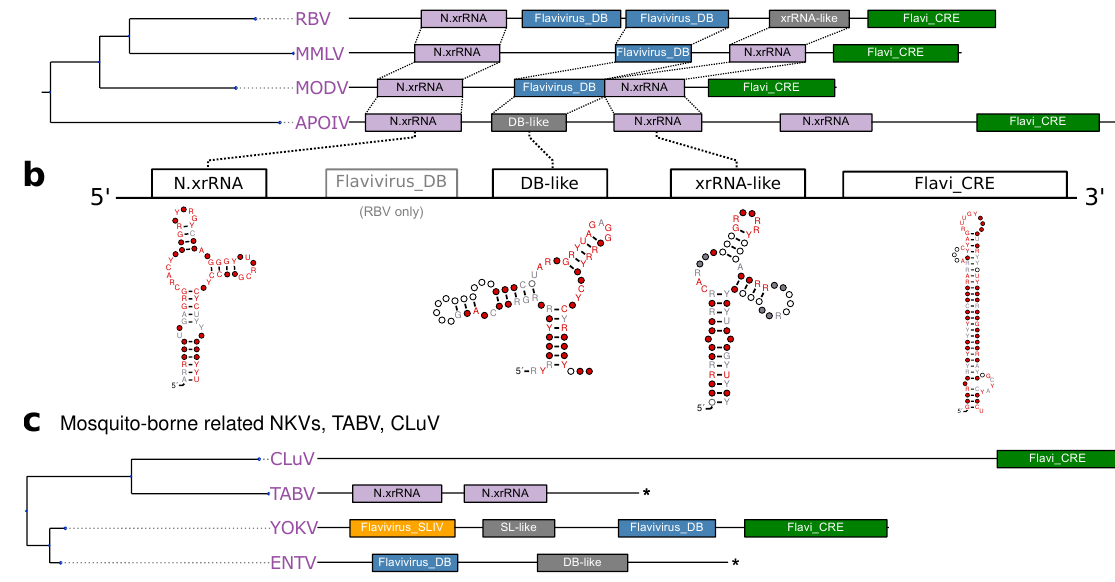
Figure 6. ( a , c ) Annotated 3 (cid:48) UTRs of NKVs. Asterisks denote incomplete 3 (cid:48) UTR sequences. ( b ) Schematic of TBFV-associated NKV-FV UTR architecture with consensus structures of NKV structure